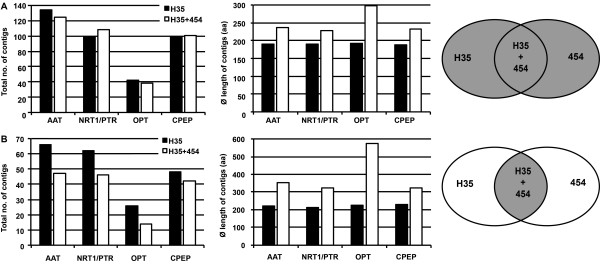
Number and average length of unigenes encoding putative N transporters and cysteine peptidases. (A) Total number and average length of contigs after assembly of all N transporter and cysteine peptidase unigenes available from RNA-seq and H35. (B) Number and length of N transporter and cysteine peptidase contigs containing sequence information overlapping between the two sources. Black bars represent H35 information, white bars show results after combining H35 and RNA-seq unigenes. Gray-shaded areas in the ellipses at the right-hand side represent the origin of the sequences.